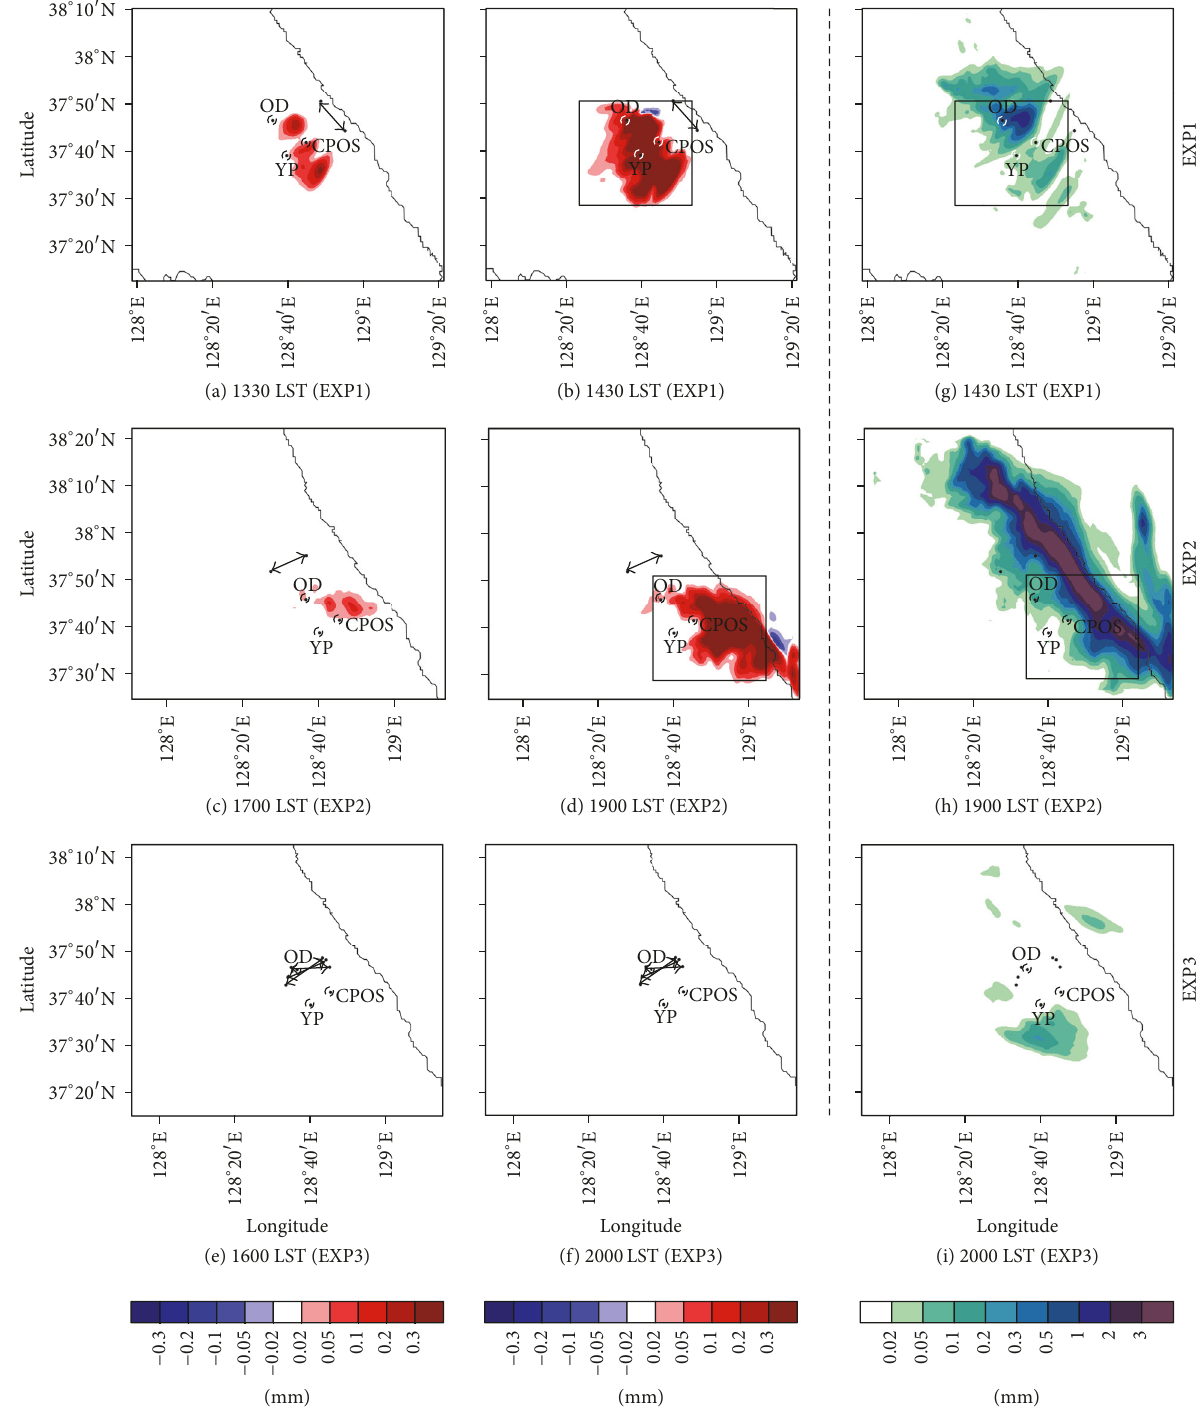
Figure 6: (a, b, c, d, e, f) Differences between the accumulated SEED and NOSEED precipitation (mm; SEED − NOSEED) from the start of model run until (a) 1330 LST and (b) 1430 LST in EXP1, (c) 1700 LST and (d) 1900 LST in EXP2, and (e) 1600 LST and (f) 2000 LST in EXP3. (g, h, i) Accumulated precipitation in NOSEED run from the start of model run until (g) 1430 LST in EXP1, (h) 1900 LST in EXP2, and (i) 2000 LST in